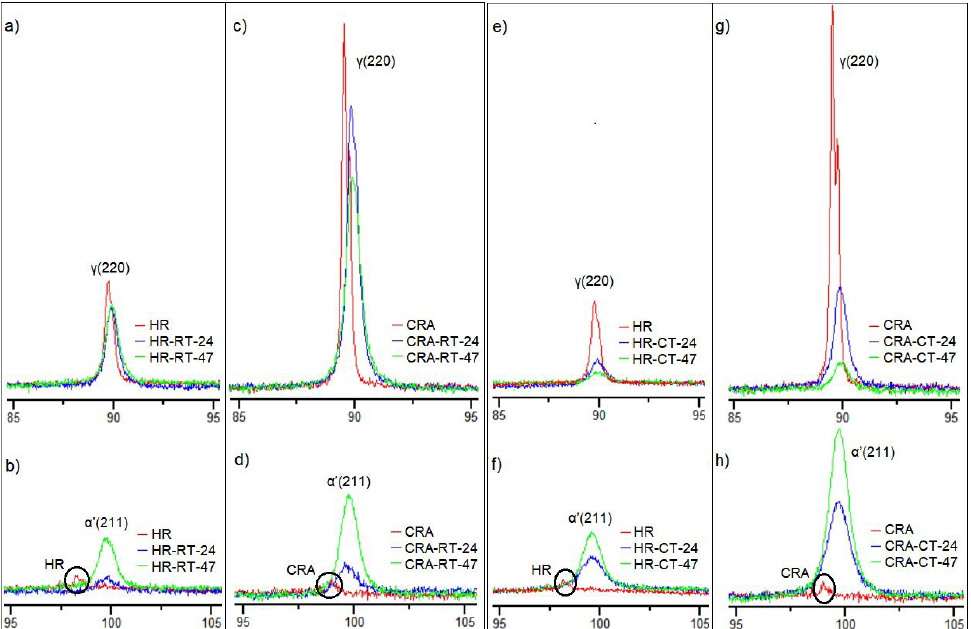
Figure 8. Displacement and/or widening peaks (γ and α’) after martensitic transformation at 298 K (a and b) and 155 K (c and d) by rolling.